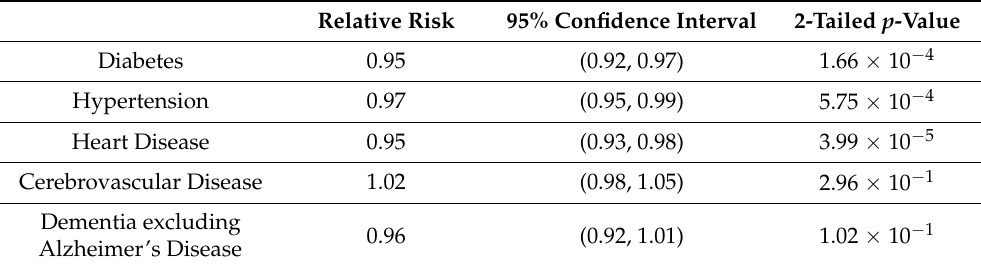
Table 1. Estimated relative risks for comorbid conditions previously associated with AD, including diabetes, hypertension, heart disease, cerebrovascular disease, stroke, and other dementia for 85,787 individuals identified to be at high-risk of AD.